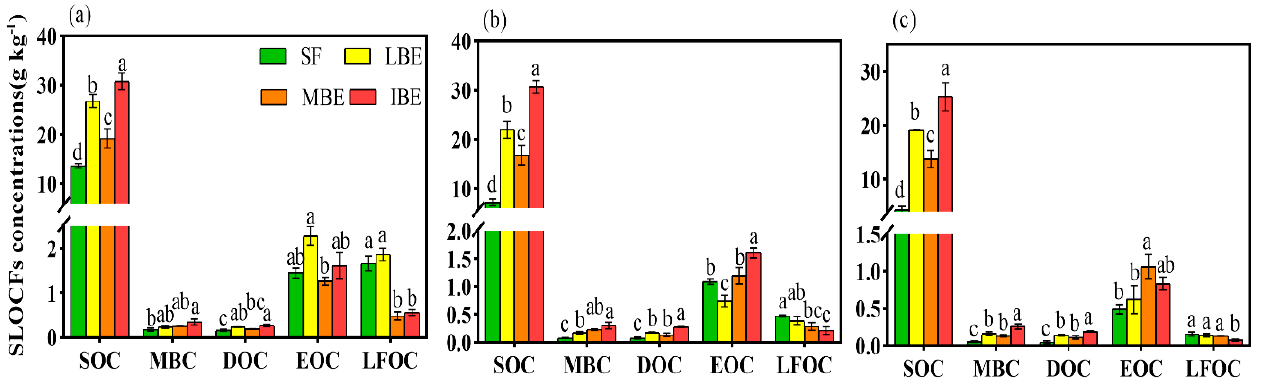
Figure 2. SLOCF concentrations at different bedrock exposure rates. SF (secondary forest); LBE (light bedrock exposure); MBE (moderate bedrock exposure); IBE (intense bedrock exposure). Different lowercase letters indicate significant differences ( p < 0.05). In the article, ( a – c ) Soil depths of 0–10 cm, 10–20 cm and 20–30 cm, respectively.